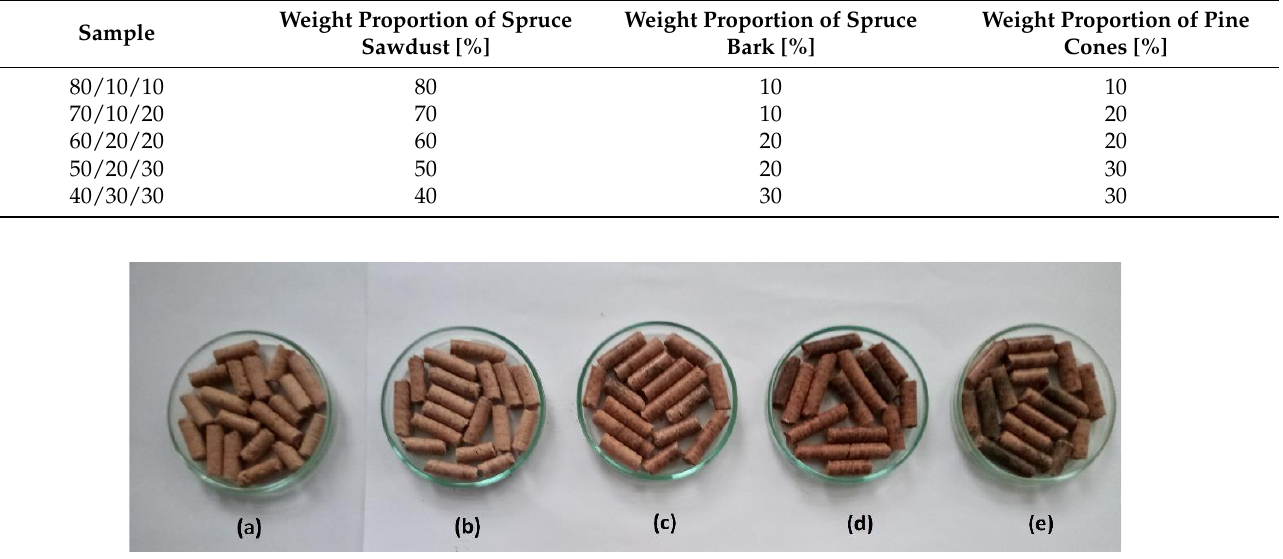
Figure 2. Individual pellet samples: ( a ) 80/10/10; ( b ) 70/10/20; ( c ) 60/20/20; ( d ) 50/20/30; ( e )